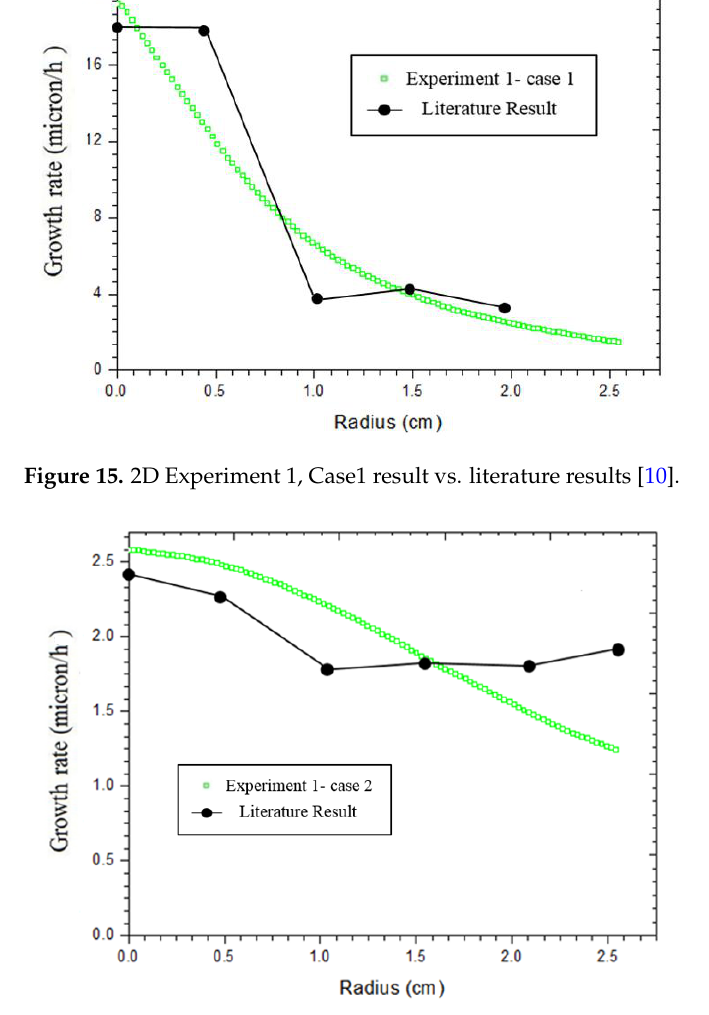
Figure 16. 2D Experiment 1, Case2 result vs. literature results [10].